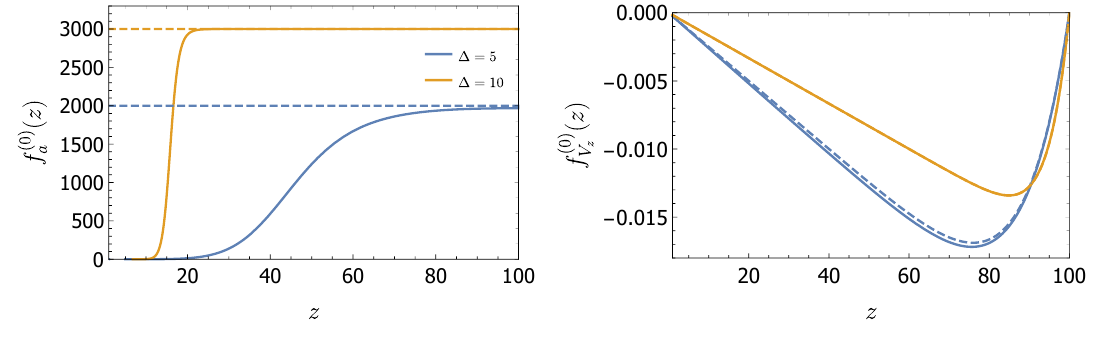
p k = 1 and the solid lines have been obtained by